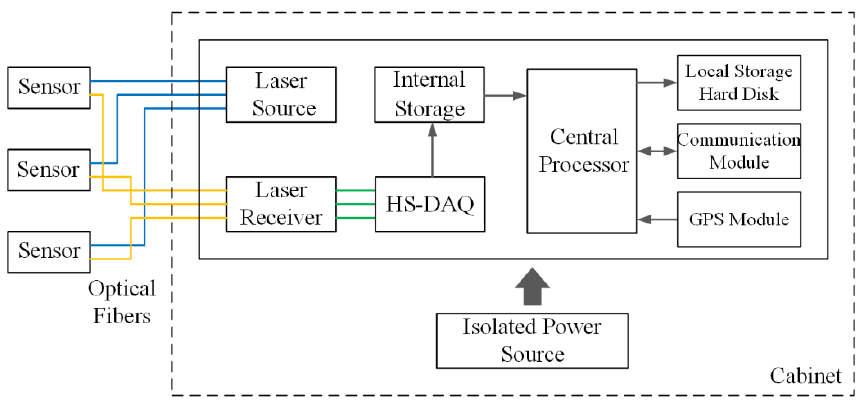
Figure 3. General connection diagram of the measuring system.